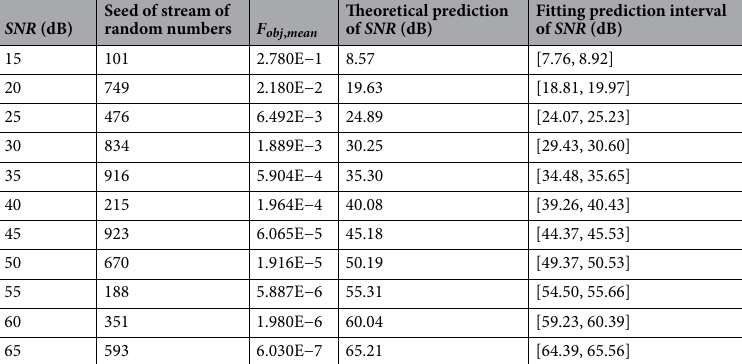
Table 4. Theoretical and fitting prediction results with SNR from 15 to 65 dB with 5dB